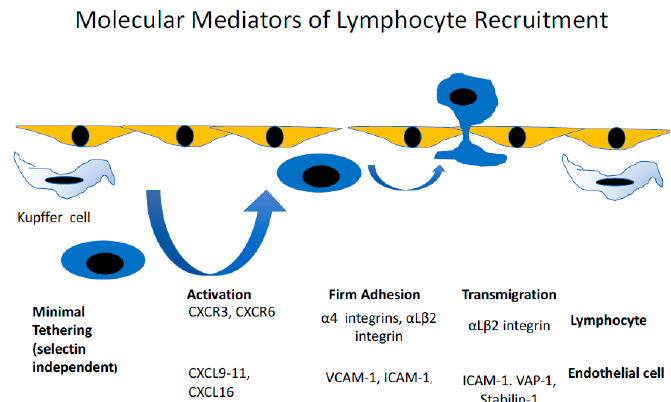
Figure 2. The molecular mechanisms of lymphocyte trafficking in liver disease. The recruitment of lymphocytes in the hepatic sinusoids is mediated by a combination of surface receptors and chemoattractant cytokines. In conventional recruitment, lymphocytes undergo a rolling step that is mediated by selectins. Selectins are absent in the sinusoidal channels, and after a brief tethering, lymphocytes undergo activation and firm adhesion mediated by a combination of chemokines presented on the endothelium and binding to chemokine receptors on the lymphocyte surface (for example, the inflammatory chemokines CXCL9, 10, and 11 binding to the chemokine receptor CXCR3, or the chemokine CXCL16 binding to CXCR6). Following activation, the lymphocytes bind via integrins to intercellular adhesion molecule-1 (ICAM-1) and vascular cell adhesion molecule-1 (VCAM-1). The final step is transendothelial migration, which has been shown to be mediated by ICAM-1, vascular adhesion protein-1 (VAP-1), and stabilin-1.